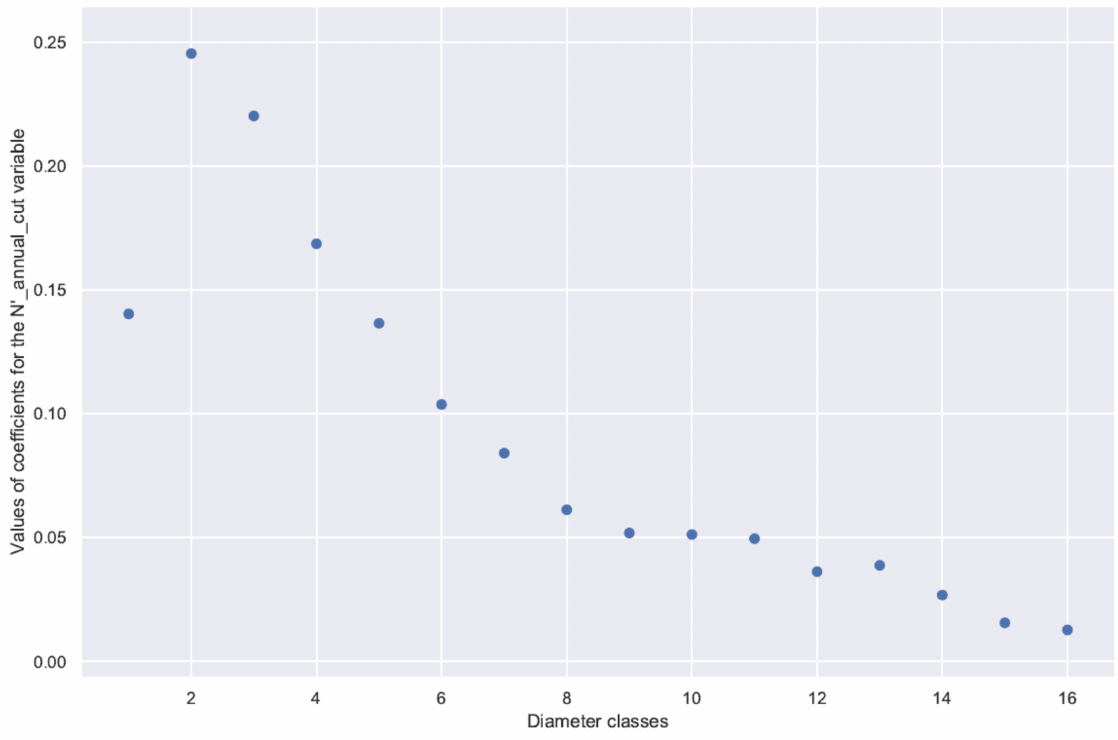
Figure 7. Regression coefficients corresponding to the transformed feature N (cid:48)